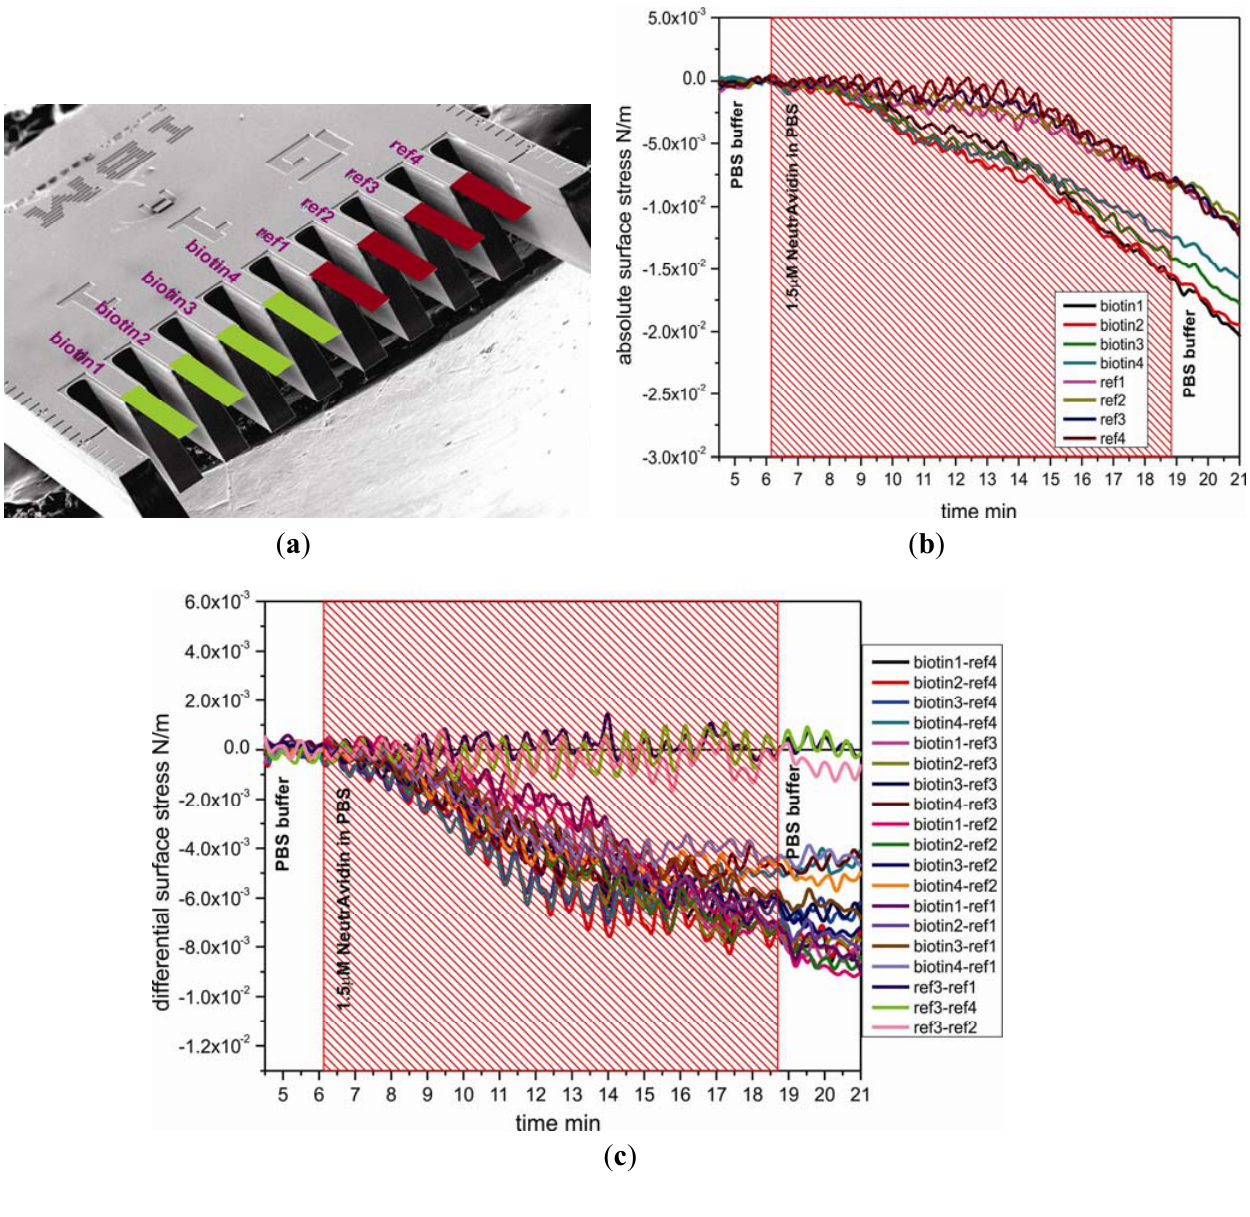
Figure 2. ( a ) Pre-functionalization of cantilevers coated with SH-C cantilever 1-4 (biotin1 to biotin4, shown in green), and with SH-C 5-8 (ref1 to ref4, shown in red, randomly selected). ( b ) Absolute bending signal after specific interaction of biotin and NeutrAvidin (hatched area) displaying different reactivity for sensors and reference cantilevers. ( c ) Differential bending signal showing a very reproducible negative signal that corresponds to compressive stress building up on the sensor cantilever. Differences between reference cantilevers show no signal. The periodic oscillation observed in the signals is due to the injection process (imperfection of the syringe pump